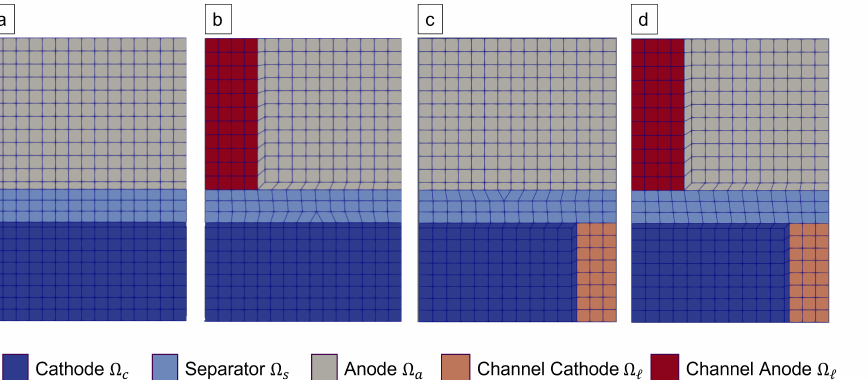
Figure 1. Periodic 2D finite element discretisation of the four different cell configurations used for fitting. We remark that Configuration ( a ) represents unstructured electrodes, which are equivalently simulated by a 1D cut as in the known Newman configuration. ( b – d ) represent the used meshes corresponding to the cell configurations as described in Section